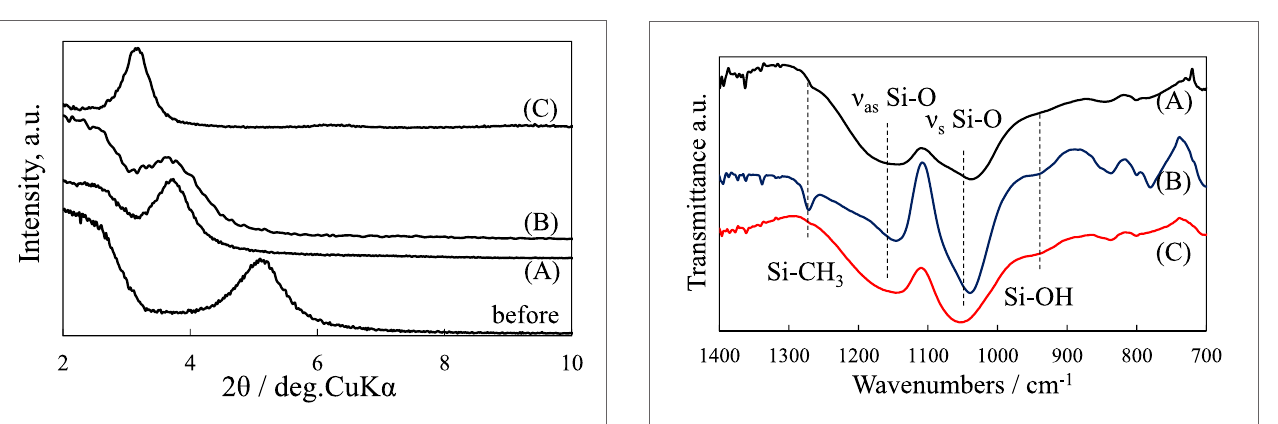
FigUre 4 | IR spectra of pillared carbons obtained from (A) C 8 SiGO-(C 1 ) 2 Si, (B) C 8 SiGO-C 1 Si, and (C) C 8 SiGO-APS.